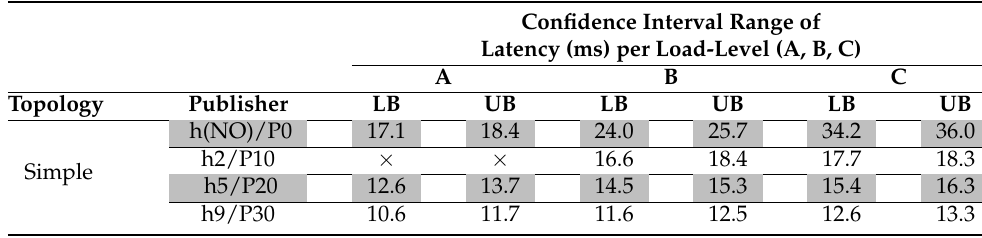
Table 6. Confidence Intervals (99% confidence) for TS and NO MQTT flows: physical